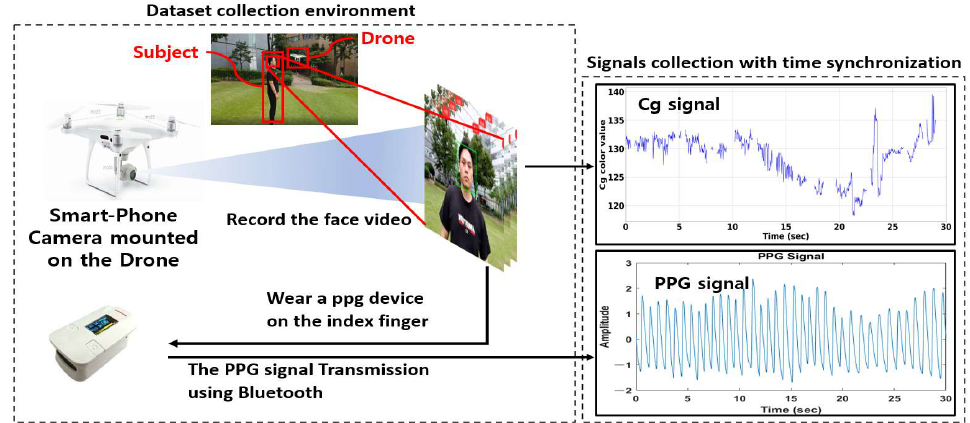
Figure 19. Dataset collection environment when flying a drone (DJI WM3315).